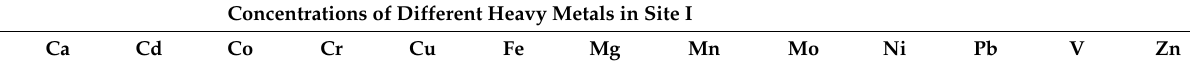
Table 5. Correlation between the concentrations of heavy metals in the soil samples of Site I (Riyadh).